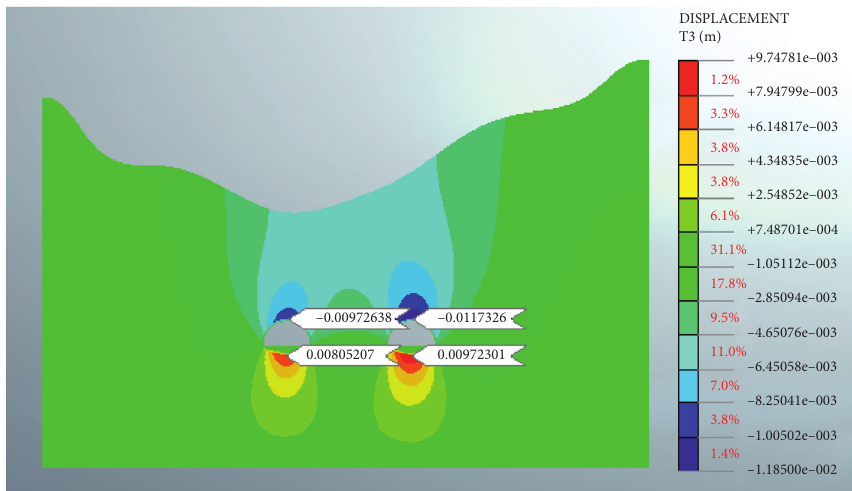
Figure 13: Vertical displacement distribution of surrounding rocks in double-side guide pit method.